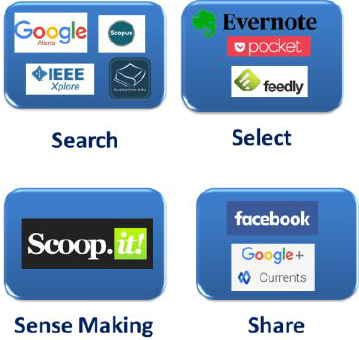
Figure 2. Content Curation Toolkit recommended to the students.